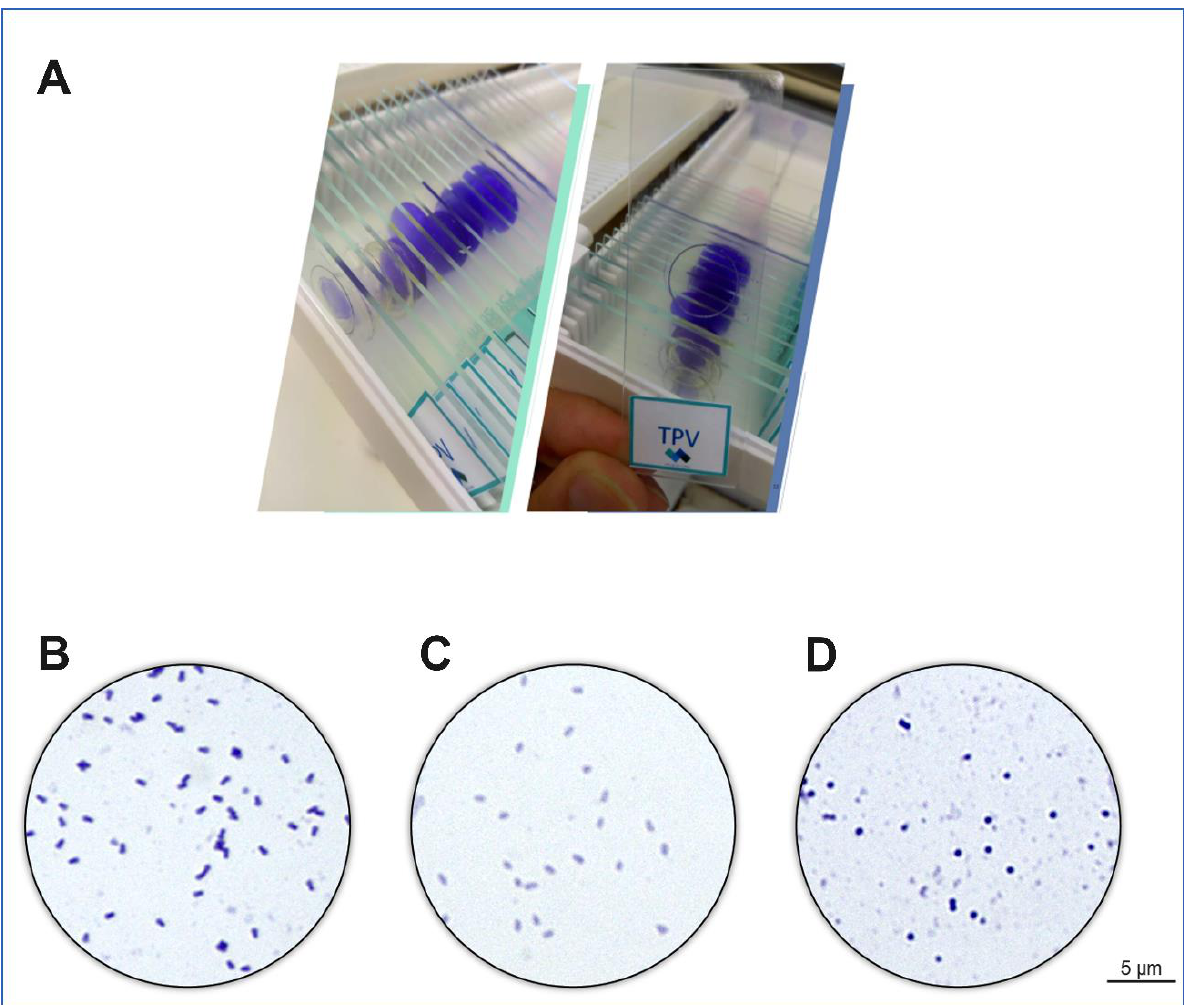
Figure 6. Optical microscopy images. ( A ) “Virus Goes Viral” kit. Source: Virology Journal, D.O.I.: 10.1186/s12985-020-1291-9. Visualization under 1000 times magnification of the stained purified particles of ( B ) tupanvirus, ( C ) cedratvirus and ( D ) Niemeyer virus, respectively.